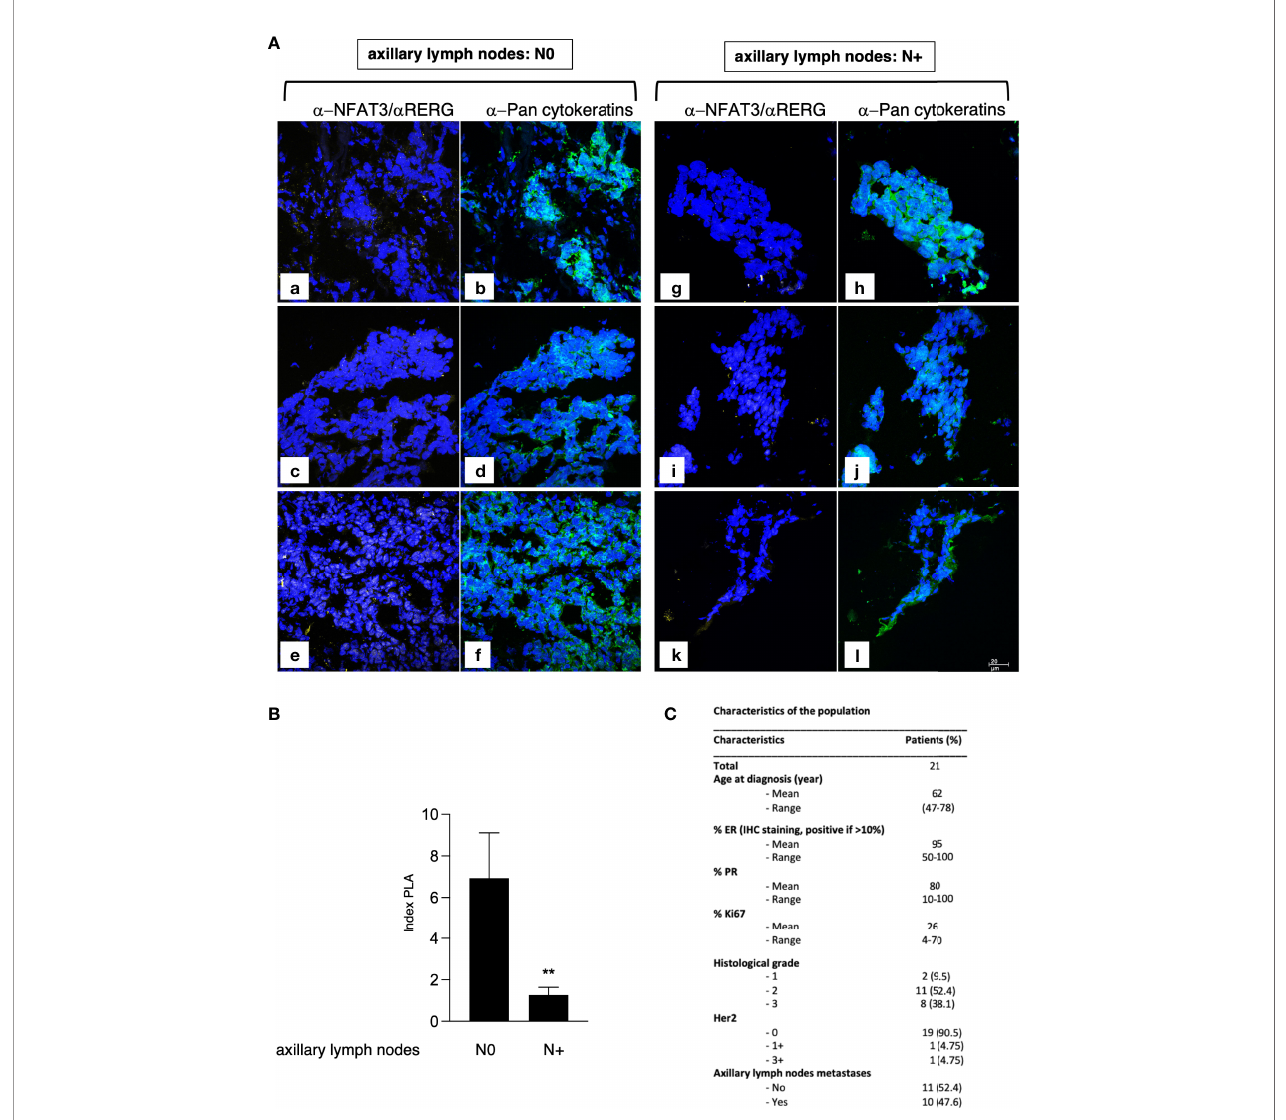
FIGURE 4 | NFAT3/RERG interaction is increased in luminal breast cancer tissues and is correlated with the absence of ALN colonization. (A) Frozen luminal breast cancer sections from patients who developed ALN colonization (N+; a-f) or not (N0; g-l) were incubated with a -NFAT3 and a -RERG followed by PLA assays (yellow dots) and labeling with a -pan cytokeratin coupled to FITC. Data from 6 representative patient slides out of 21 are shown. (B) Index of PLA was obtained by analyzing 2 random fi elds for the 21 slides; data are shown as mean ± SEM (**p<0,005). (C) Characteristics of the patients used for